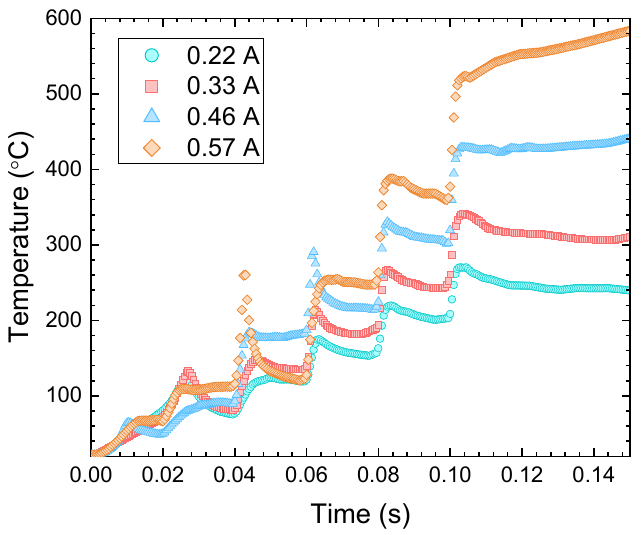
Figure 5. Estimated transient temperature variations for electric current values of 0.22, 0.33, 0.46 and 0.57 A. The rise in the temperature is in multiple steps corresponding to the stepwise current increments.